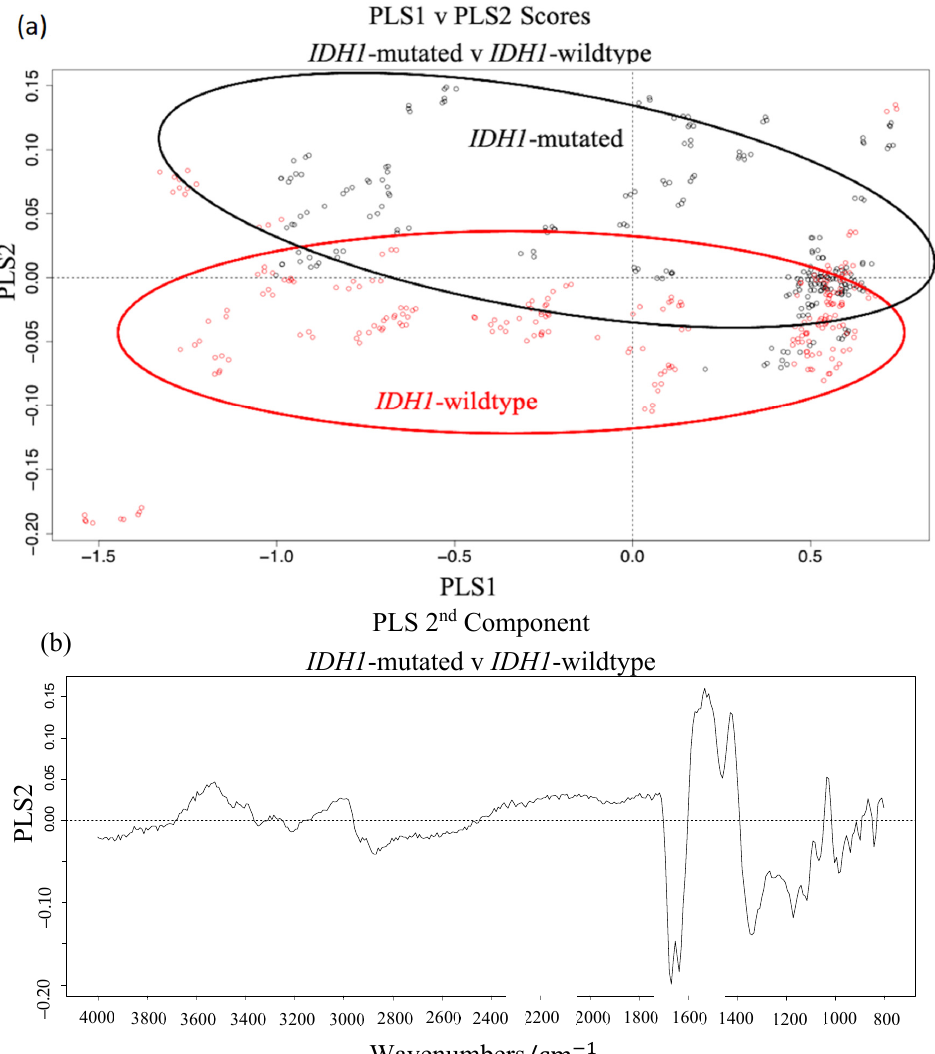
Figure 10. Single model receiver operator characteristic (ROC) graphs for the ( a ) whole serum dataset displaying the PLS-DA (blue), SVM (red) and RF (green) classifiers; and ( b ) the best performing model for each of the tested filtrate fractions: the full spectrum (4000–800 cm − 1 , blue), the fingerprint region